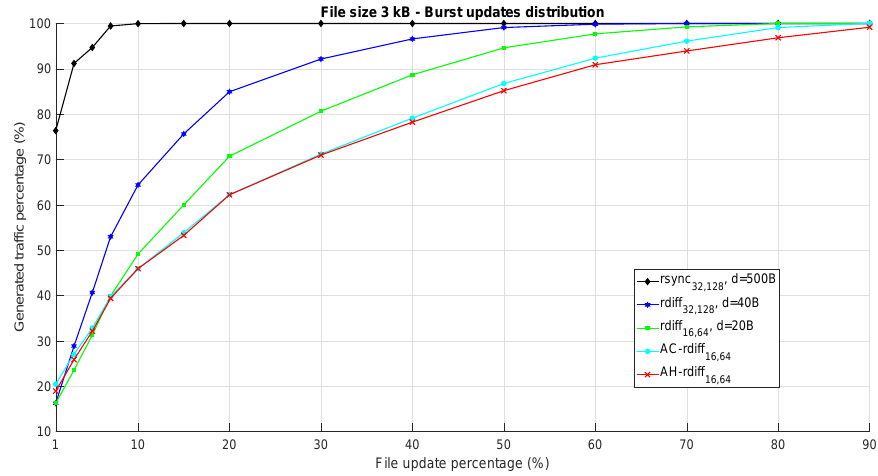
Figure 7. Performance of the considered file synchronization algorithms as a function of the file update percentage. Burst updates distribution within the file is assumed.